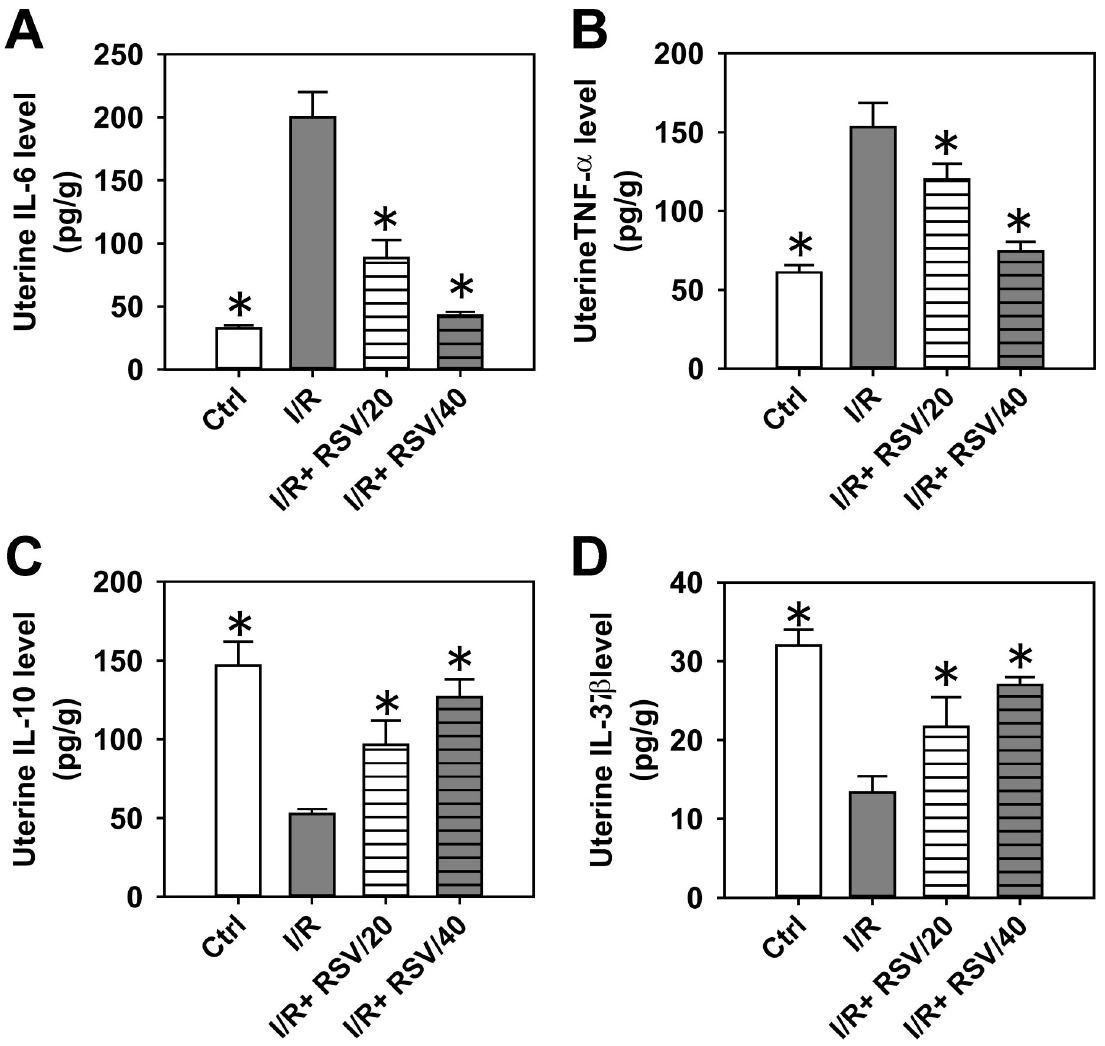
Fig 4. The effect of RSV on the inflammatory response induced by uterine I/R in rat uterus. The concentrations of IL-6 ( A ), TNF- α ( B ), IL-10 ( C ) and IL-37 ( D ) in rat uterus in control, I/R, I/R+RSV/20, and I/R+RSV/40 groups were examined by ELISA. Bars represent means ± SD, n = 3. � P < 0.05 vs . I/R